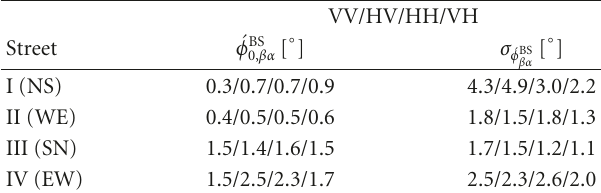
Table 8: Best-fit parameters of P βα ( ´ φ BS